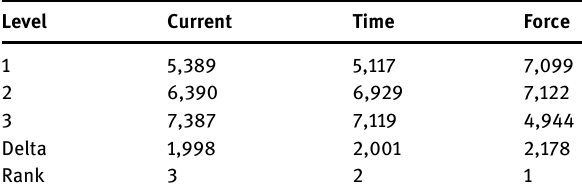
Table 5: The response table for mean values